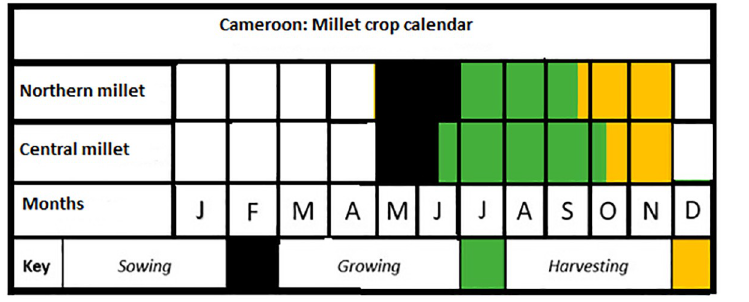
Fig 4. Millet crop calendar for Cameroon. Source: Authors’